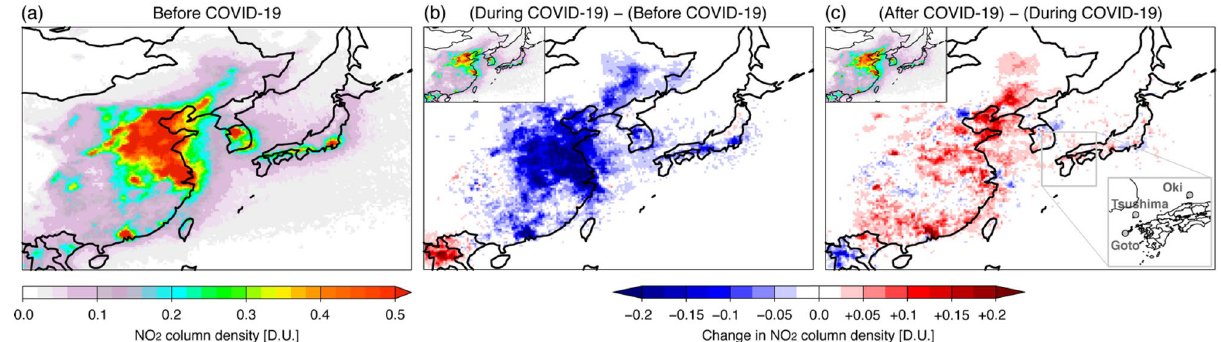
Figure 1. Satellite-measured tropospheric NO 2 column density over East Asia: ( a ) before COVID-19; ( b ) difference between during COVID-19 and before COVID-19; ( c ) difference between after COVID-19 and during COVID-19. The analysed period is the average of February and March. The inset in the upper left of ( b ) and ( c ) shows the absolute values during and after COVID-19, respectively. The inset in the lower right of ( c ) shows the three observation sites analysed in this study. The maps were generated with gtool3 (http:// www. gfd- dennou. org/ libra ry/ gtool/ index. htm.